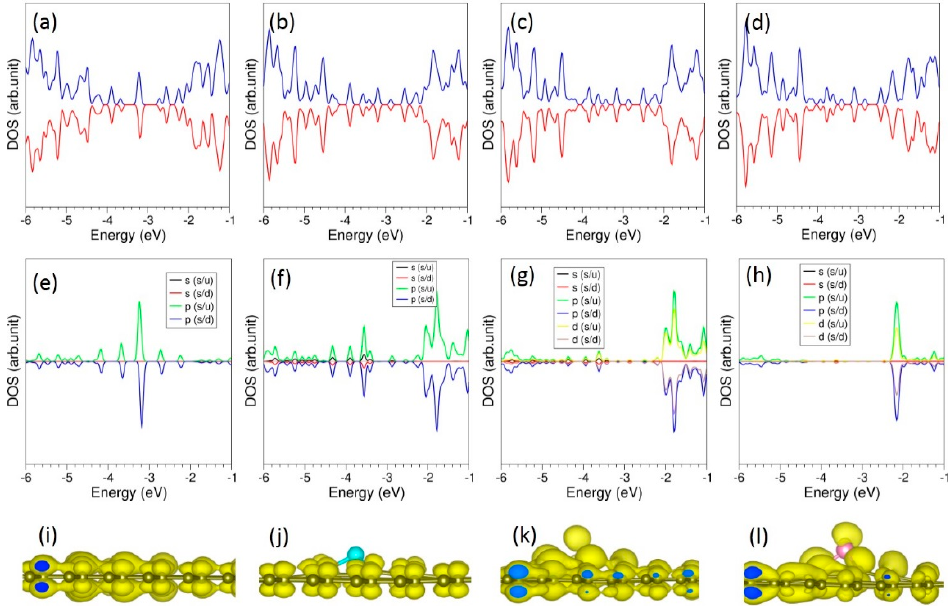
Figure 8. Total DOS plots of ( a ) O-, ( b ) S-, ( c ) Se- and ( d ) Te-doped graphene. Corresponding atomic DOS plots ( e – h ) and charge density plots associated with the doped atoms ( i – l ) are also